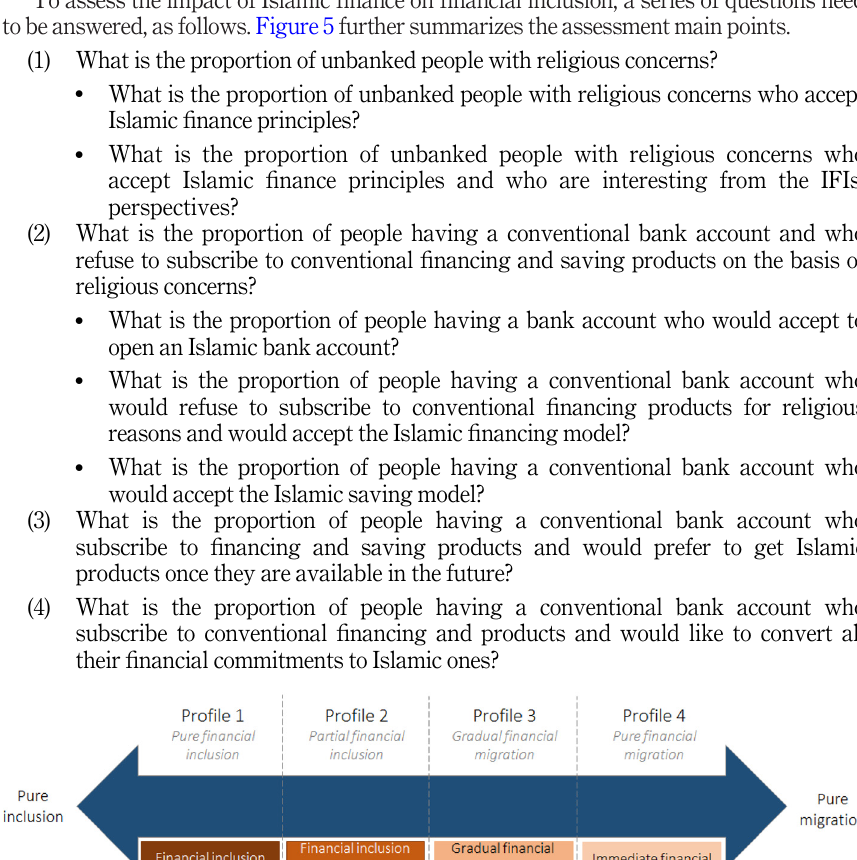
Figure 4. Pro fi les of customers – inclusion or